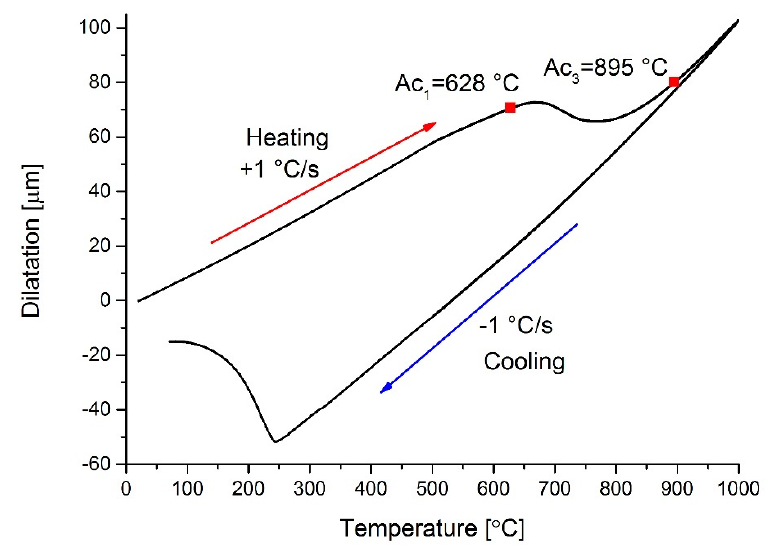
Figure 2. Dilatometry, Ac 1 and Ac 3 point determination.